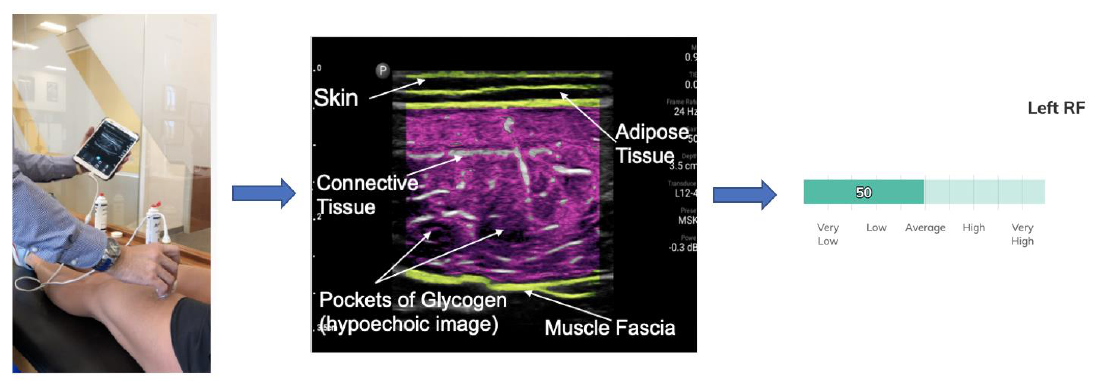
Figure 1. Muscle scan of rectus femoris (RF) being captured, followed by MuscleSound ® cropping and staining based on echogenicity of the muscle, resulting in a score measured by MuscleSound ® software, according to Hill and San-Millan [9]